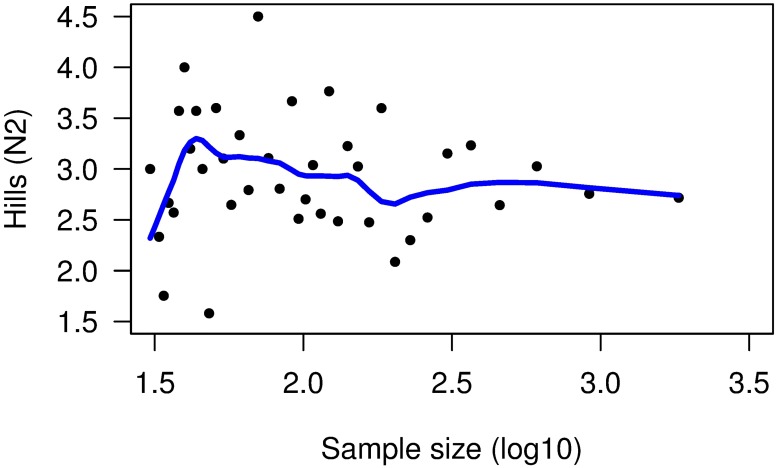
Systematic sampling of the test set.Hill’s N2 Diversity index is plotted against the log10-transformed number of frames sampled. The blue line is the LOWESS (locally weighted) regression line that levels out around 102.6 (398 frames).